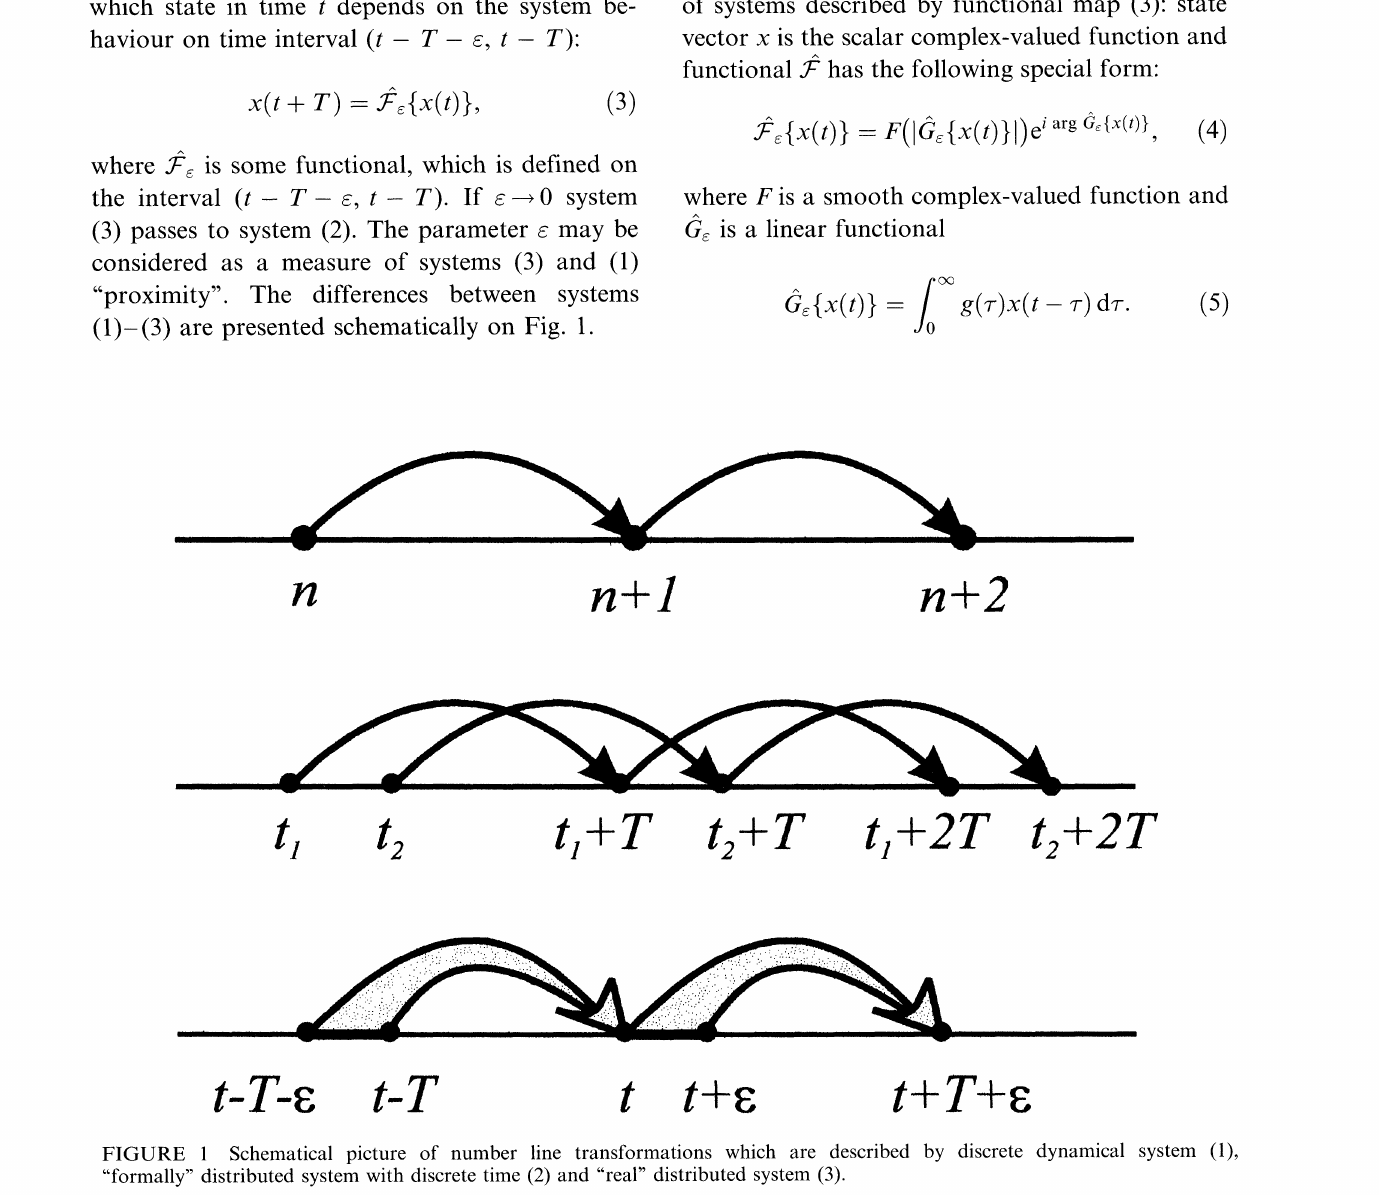
Schematical picture of number line transformations which are described by discrete dynamical system (1), "formally" distributed system with discrete time (2) and "real" distributed system